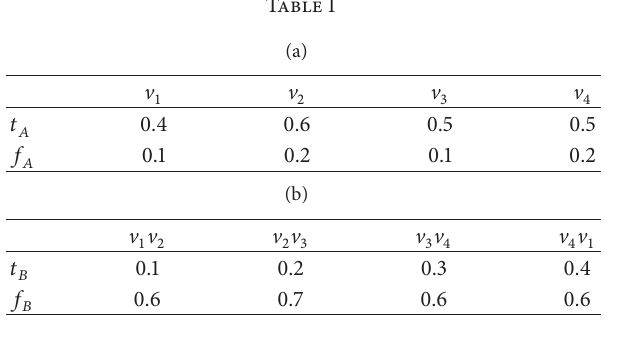
Figure 2: Vague graph.